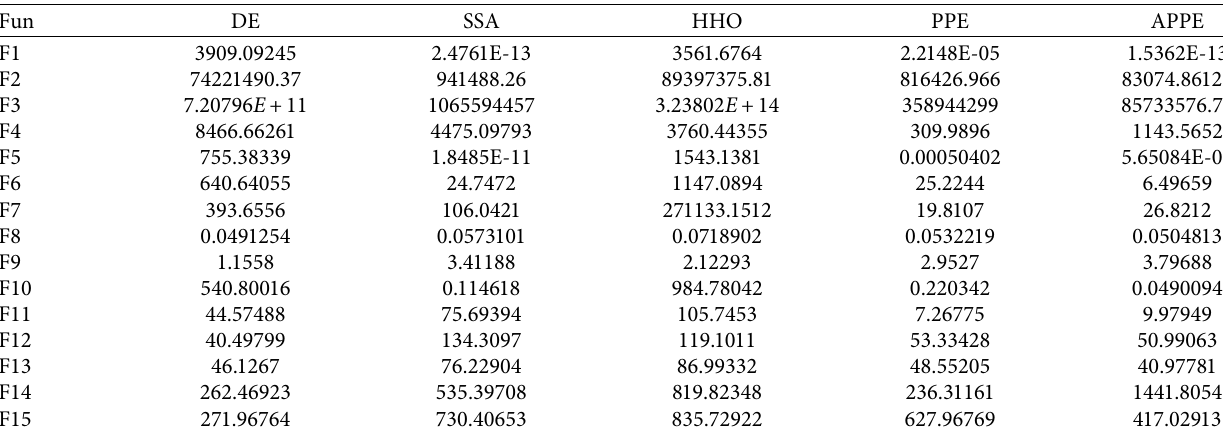
Table 8: Comparison of the standard deviation results of 51 runs on 30D in 28 benchmark